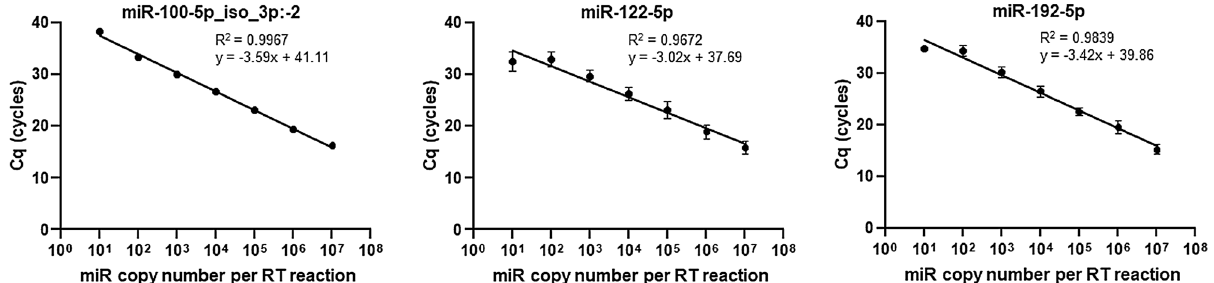
Figure 3. Dynamic range and sensitivity of the evaluated RT-qPCR. Standard curves for miR-100-5p_ iso_3p:−2, miR-122-5p, and miR-192-5p assayed with the study RT-qPCR assay. As an internal positive control, 10 4 copies of the cDNA derived from each miR synthetic oligonucleotide were added to confirm the detection onto the standard curve. As negative controls, we tested 10 4 copies of the other miRs and RNU6B to ensure no cross-amplification. The RT-qPCR assay exhibited an excellent linearity between the log of the miR input and Cq values over seven orders of magnitude and accurately quantified down to 10 cDNA copies of miR. Measurements were set up in quintuplicate (Supplementary Table 1). Pearson correlations were used for statistical were highly expressed (Table 1), again strongly suggesting why the commercial TaqMan assay could detect and accurately quantify these miRs. To specifically and cost-effectively quantify expression of miR-100-5p, we adapted a previously described RT- qPCR method for miR quantification 18 . This method uses SYBR Green detection chemistry and a single reverse transcription reaction for all miRs combined with real-time PCR with two miR-specific DNA oligonucleotides (Fig. 2). In this method, purified RNA containing miRs is polyadenylated with adenosine and poly adenosine polymerase. Next, polyadenylated RNA is reverse transcribed with RT and an anchored poly deoxythymidine oligonucleotide. The resulting cDNA is subjected to qPCR with two tagged specific oligonucleotides. We designed specific oligonucleotides for the amplification and quantification of the miR-100-5p_iso_3p:−2 variant (Fig. 2) and the canonical miR-122-5p and miR-192-5p sequences. To confirm the specificity of the described assay, we applied melting curve analysis (Supplementary Fig. 1). The sensitivity and dynamic range of the described RT- qPCR were evaluated using synthetic miR-100-5p, miR-122-5p, and miR-192-5p as targets. A cDNA dilution series spanning eight orders of magnitude was prepared ranging from 10 to 10 7 copies of miR-100-5p_iso_3p:−2, miR-122-5p, or miR-192-5p molecules per RT reaction. The RT-qPCR assay exhibited an excellent linearity between the log of the miR input and quantification cycle (Cq) values over seven orders of magnitude and accu- rately quantified down to 10 cDNA copies of miR-100-5p_iso_3p:−2, miR-122-5p, or miR-192-5p corresponding to 10 miRs in the original sample (R 2 = 0.9967, R 2 = 0.9672, and R 2 = 0.9839, respectively; Fig. 3, Supplementary Table 1). The intra-assay coefficients of variation for the three tested miRs were 0.81% for miR-100-5p_iso_3p:−2, 0.97% for miR-122-5p, and 1.60% for miR-192-5p. The inter-assay coefficients of variation with these three miRs also were good (0.96%, 2.55%, and 1.72%, respectively). Of note, canonical miR-100-5p designed oligonucleotides were not able to amplify a synthetic miR-100-5p_iso_3p:−2 cDNA target template and shorter isomir cDNA